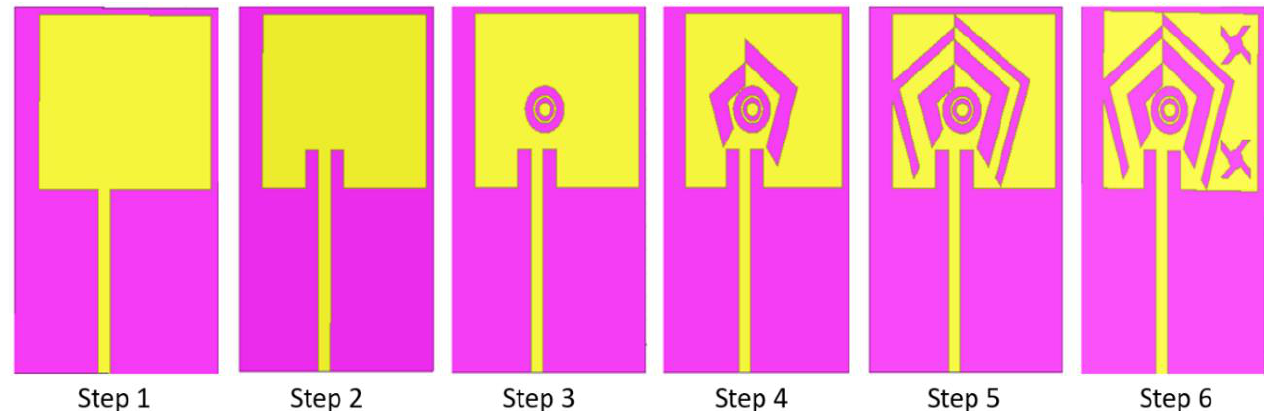
Figure 2. Antenna design steps: successive modification of the antenna geometry until the proposed solution.